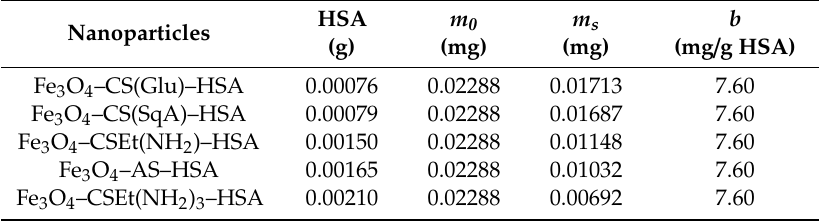
Table 4. Results of immobilized HSA interaction with KP solution under normal conditions.